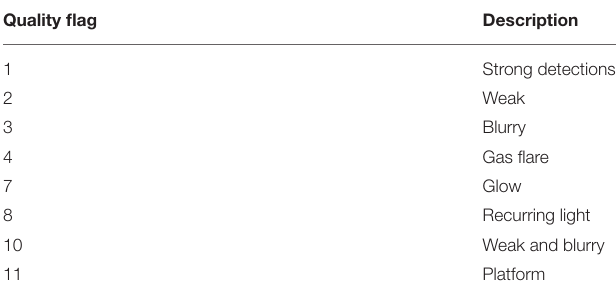
TABLE 2 | VBD quality flags. Quality